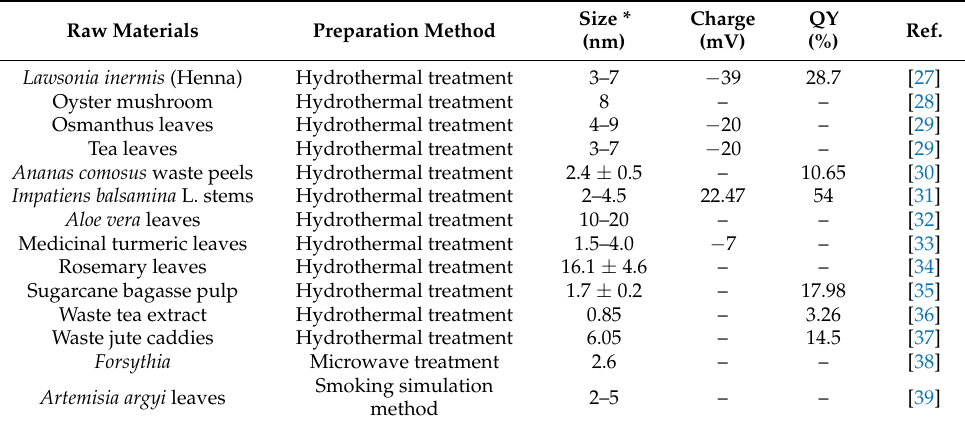
Table 1. Nitrogen-doped CDs derived from biomass for killing